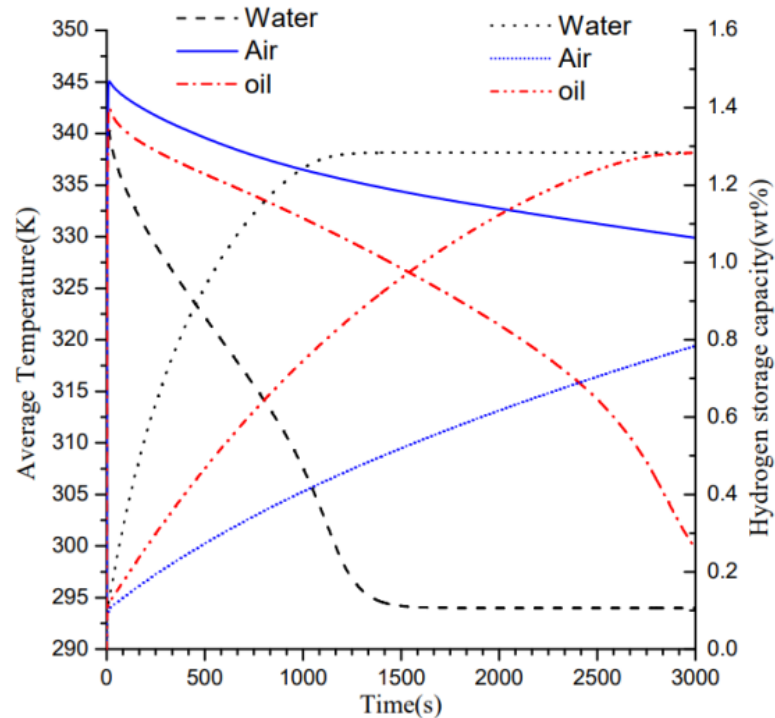
Figure 13. Time-varying curves of average temperature and the percentage by weight of hydrogen storage capacity in the reaction zone with different cooling media.